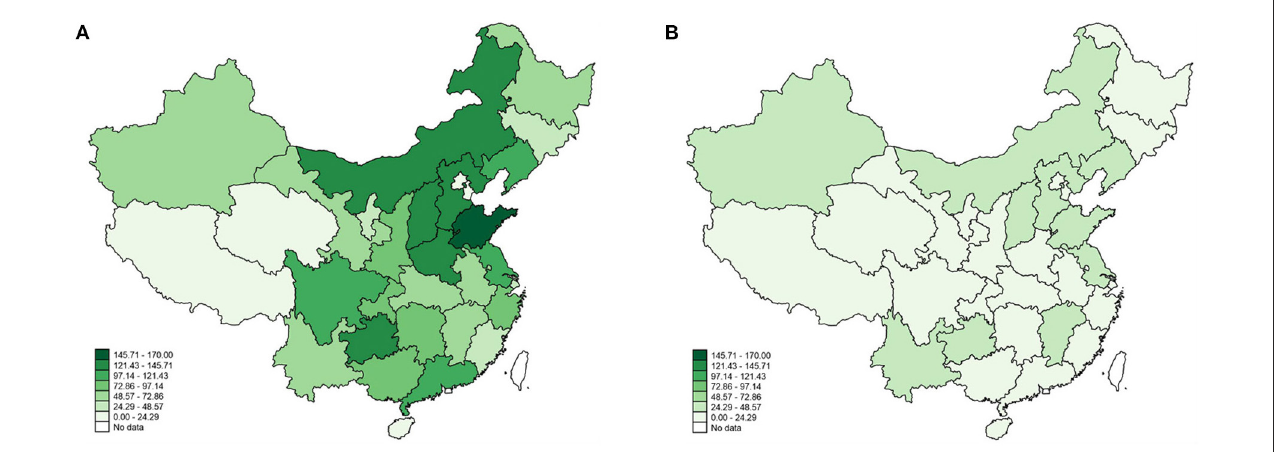
FIGURE1 Sulfur dioxide emission in (A) 2008 and (B)